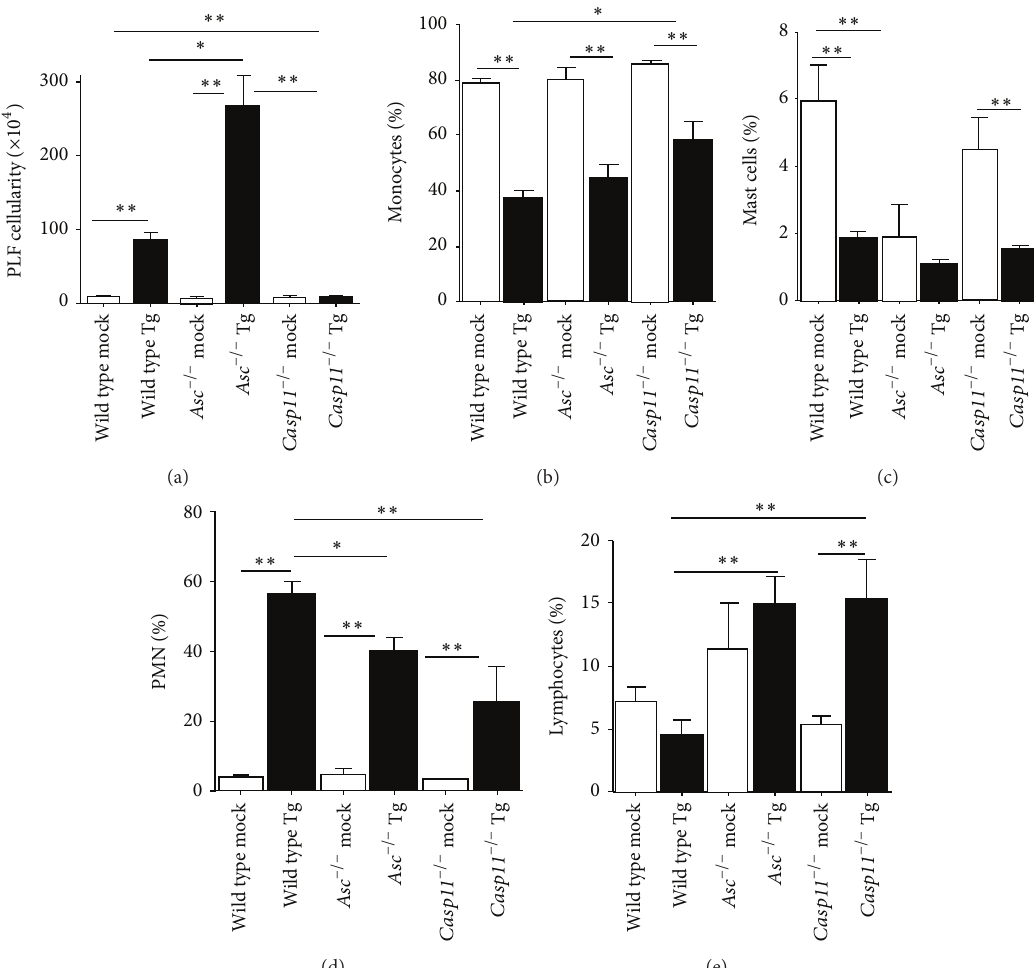
Figure 4: Peritoneal inflammation was significantly attenuated in Casp11 −/− mice. Wild type, Casp11 −/− , and Asc −/− mice were infected with 1,000 Toxoplasma gondii Me49 tachyzoites via i.p. administration and peritoneal lavage fluid (PLF) was collected 15 days after inoculation. (a) Total PLF cellularity was determined for each treatment group using trypan blue staining and a hemacytometer. (b–e) PLF leukocyte populations were determined following differential staining of cytospun samples. The percentages of monocytes (b), mast cells (c), polymorphonuclear cells (neutrophils and eosinophils) (d), and lymphocytes (e) were determined for each animal. ∗ 𝑝 < 0.05 ; ∗∗ 𝑝 < 0.01 . Data shown are representative of histopathology evaluated over the course of 3 independent studies. Wild type mock, 𝑛 = 9 ; Asc −/− mock, 𝑛 = 9 ; Casp11 −/− mock, 𝑛 = 6 ; wild type Tg, 𝑛 = 18 ; Asc −/− Tg, 𝑛 = 18 ; Casp11 −/− Tg, 𝑛 = 13 . Data shown are representative of 3 independent